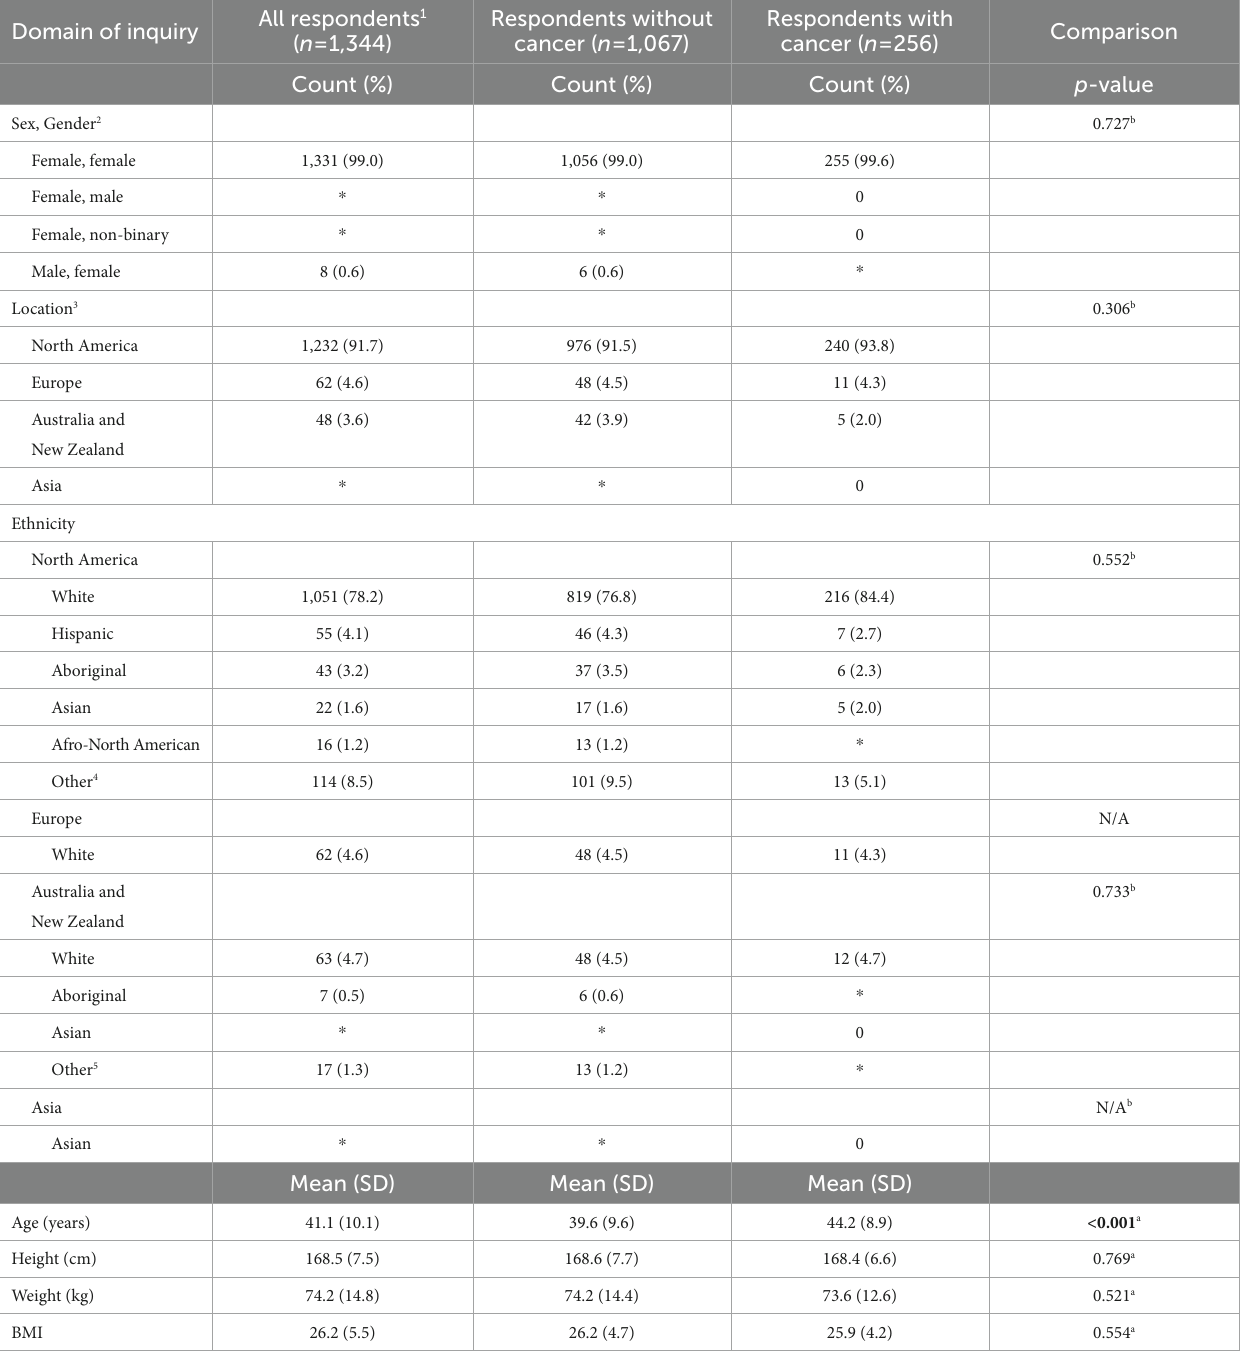
TABLE 1 Demographic characteristics of female firefighter survey respondents, by presence and absence of